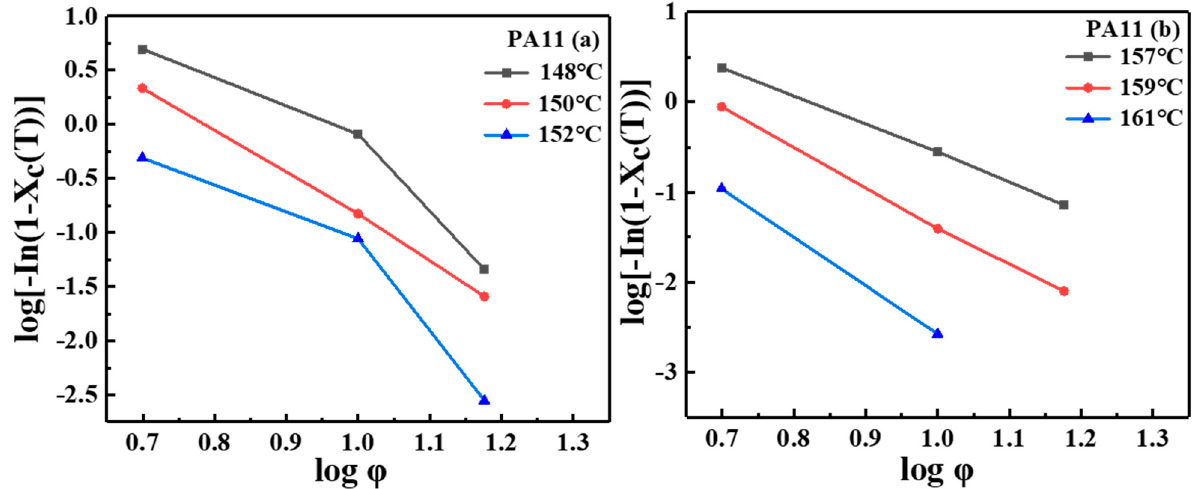
Figure 5. Plot of 𝑙𝑜𝑔(cid:4670) ﹣ 𝐼𝑛(1 ﹣ 𝑋 (cid:3030) (𝑡))(cid:4671) versus 𝑙𝑜𝑔𝜑 for two PA11 specimens.